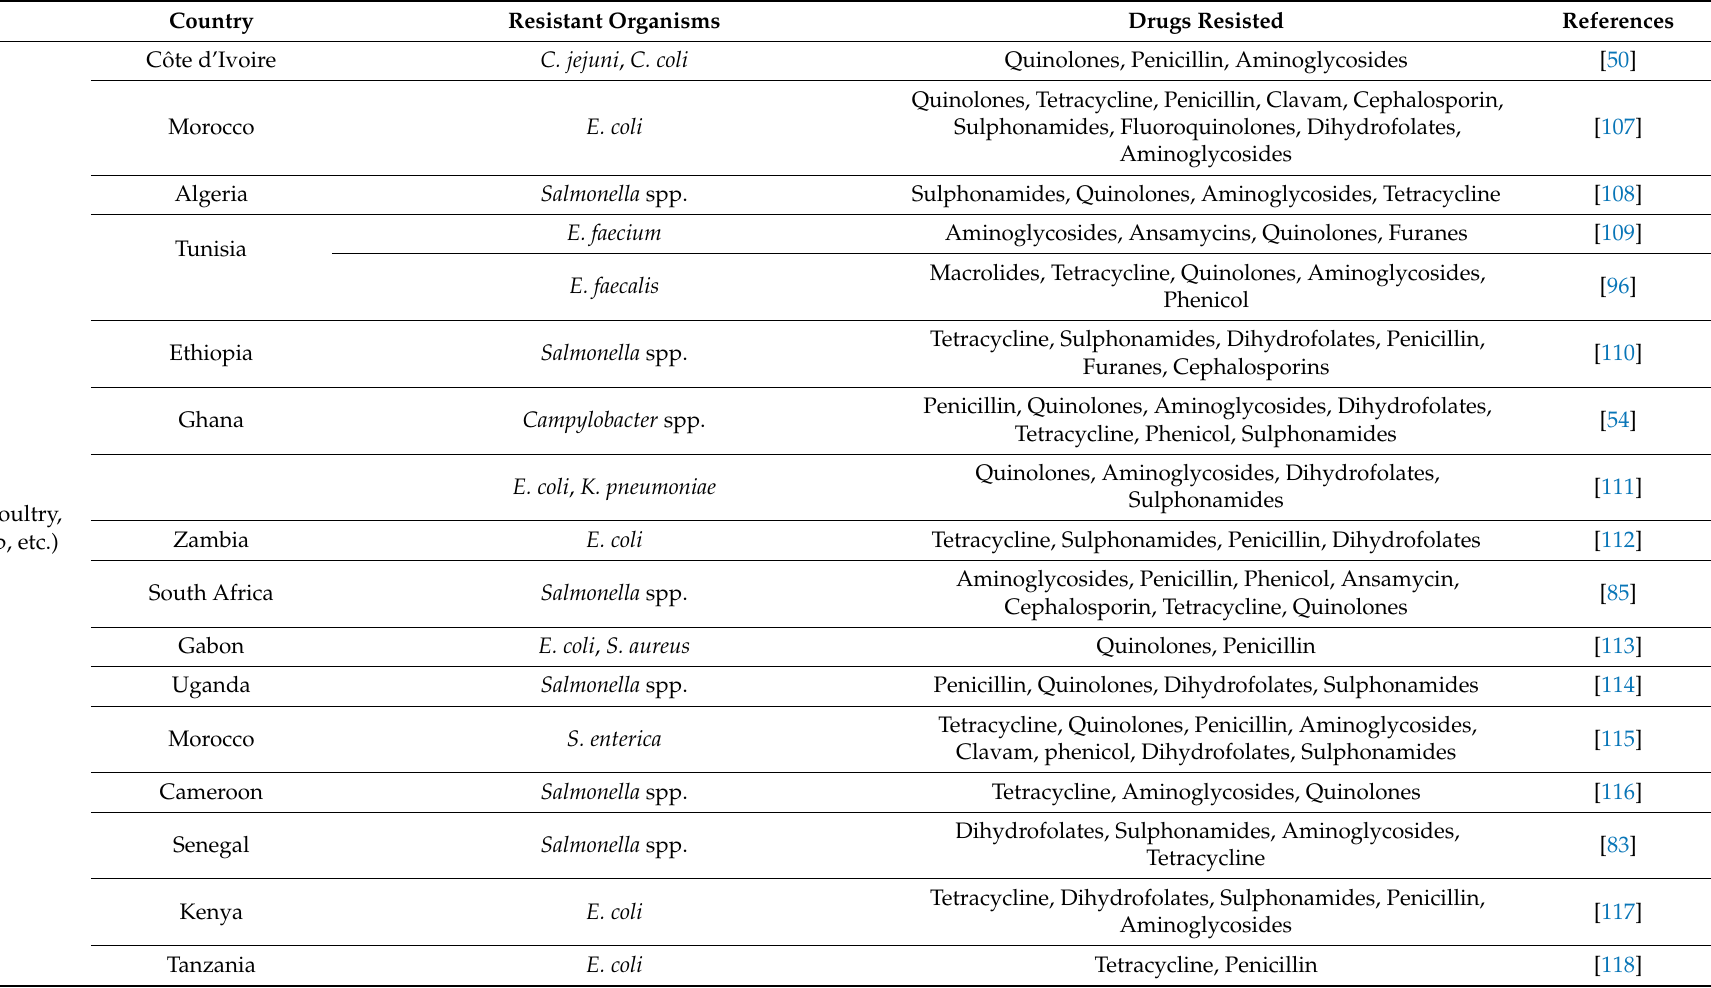
Table 4. Antimicrobial resistance reported from different food